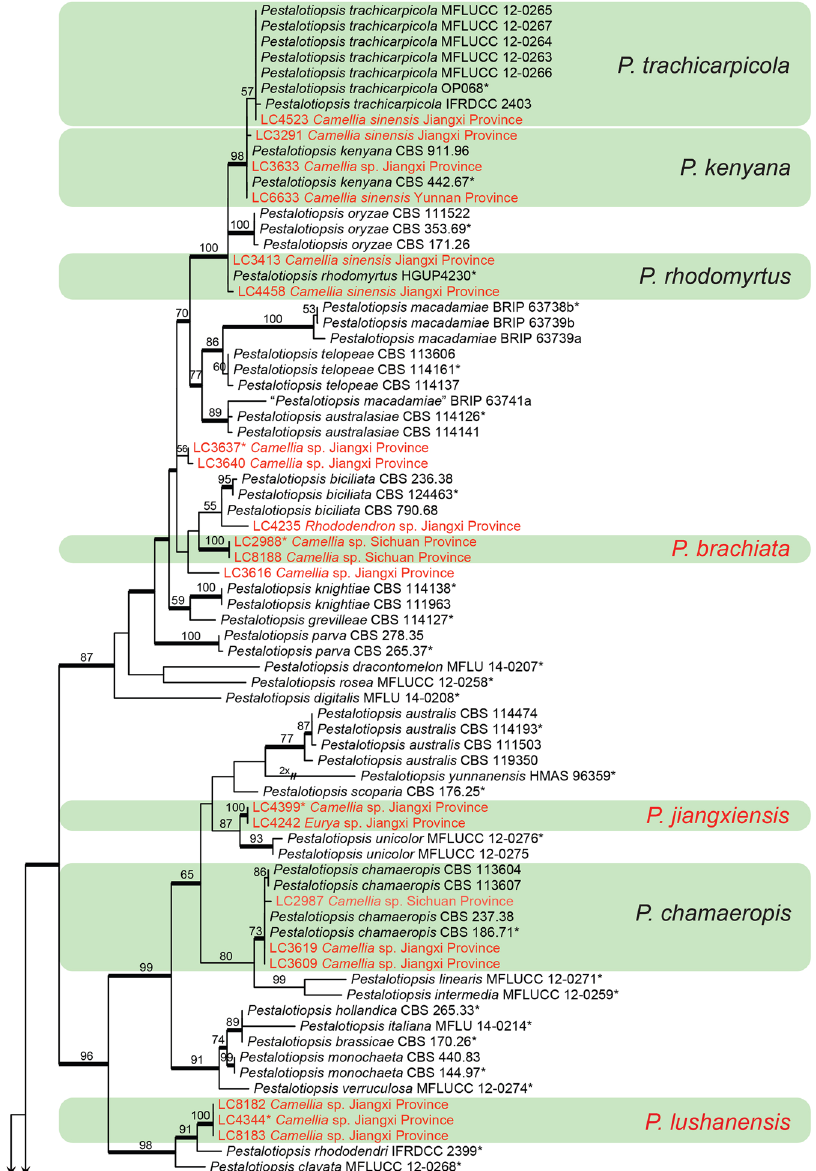
Figure 2. Part a of the phylogenetic tree of Pestalotiopsis calculated with maximum likelihood analysis on a combined dataset of three-locus sequences (ITS, TUB2, TEF) by running RAxML v.7.0.3, followed by Fig. 3. The RAxML bootstrap support values ( > 50%) are displayed at the nodes. Thickened branches indicate branches also present in the Bayesian tree with > 0.95 posterior probabilities. Stars indicate ex-type cultures. Strains from Camellia spp. in this study are in red